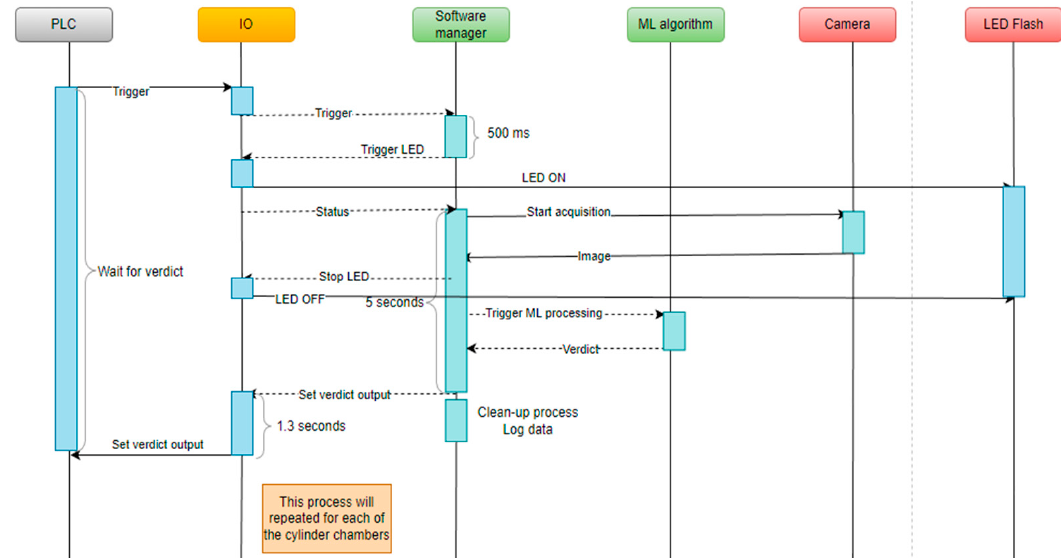
Figure 6. Process sequence diagram .